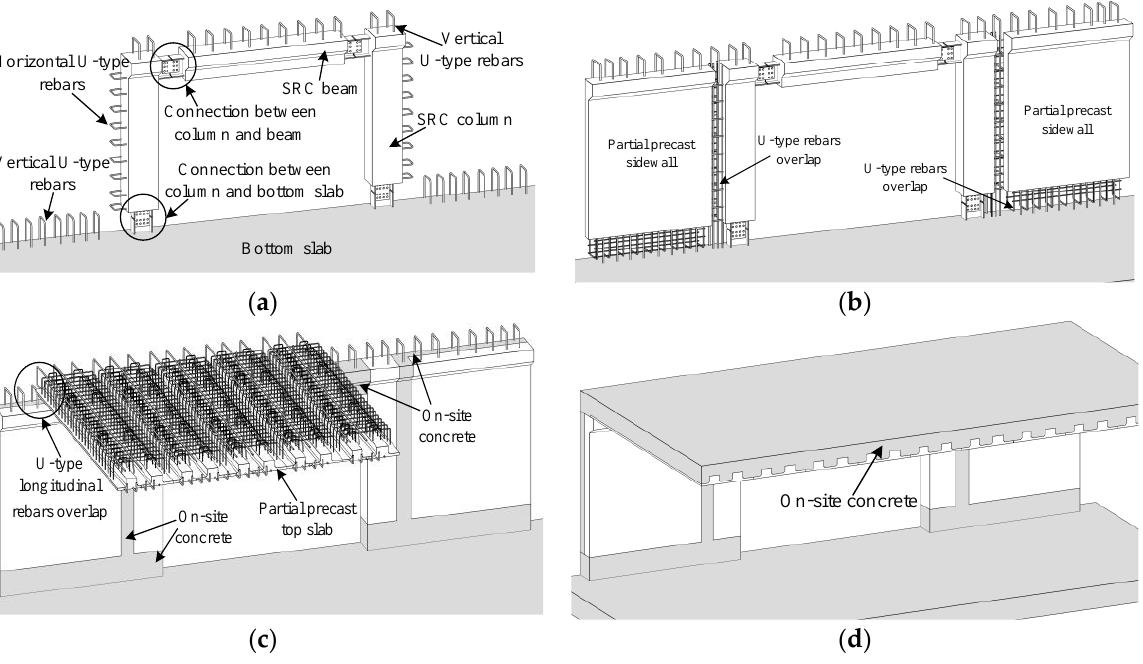
Figure 1. Developed entrance system and assembly process: ( a ) entrance frame in assembly, ( b ) sidewalls connected to entrance frame, ( c ) top slab connected to frame and sidewalls, and ( d ) assembled entrance system